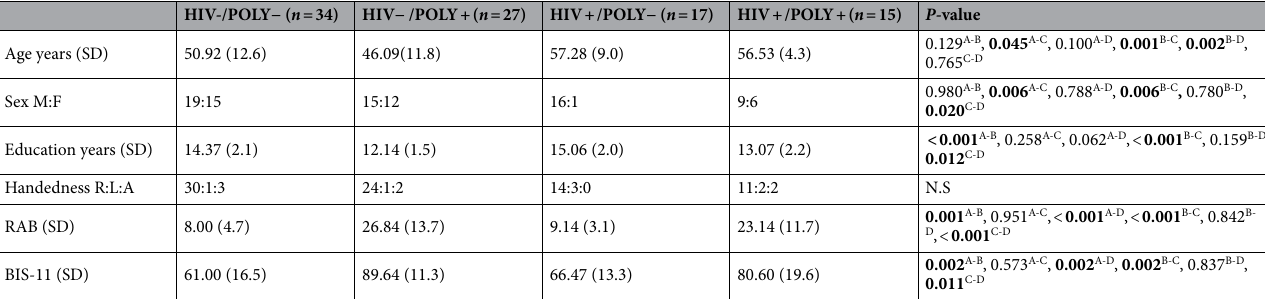
Table 1. Demographics of the four study groups ( N = 93). When a variable contained data from all 4 groups, an ANOVA (or Pearson Chi-Square for categorical variables) was performed first in order to determine significant group differences. Statistics from post-hoc comparison are reported in the table as follows: A = HIV-/POLY-, B = HIV-/POLY + , C = HIV + /POLY-, D = HIV + /POLY + . Group comparisons are indicated by the two letters as marked (e.g., A-B indicates Group A vs. Group B). N.S. = not significant, per original omnibus test and no post-hoc comparisons were conducted; SD = standard deviation, M:F = male: female, R:L:A = right: left: ambidextrous. Boldface indicates significance, p <